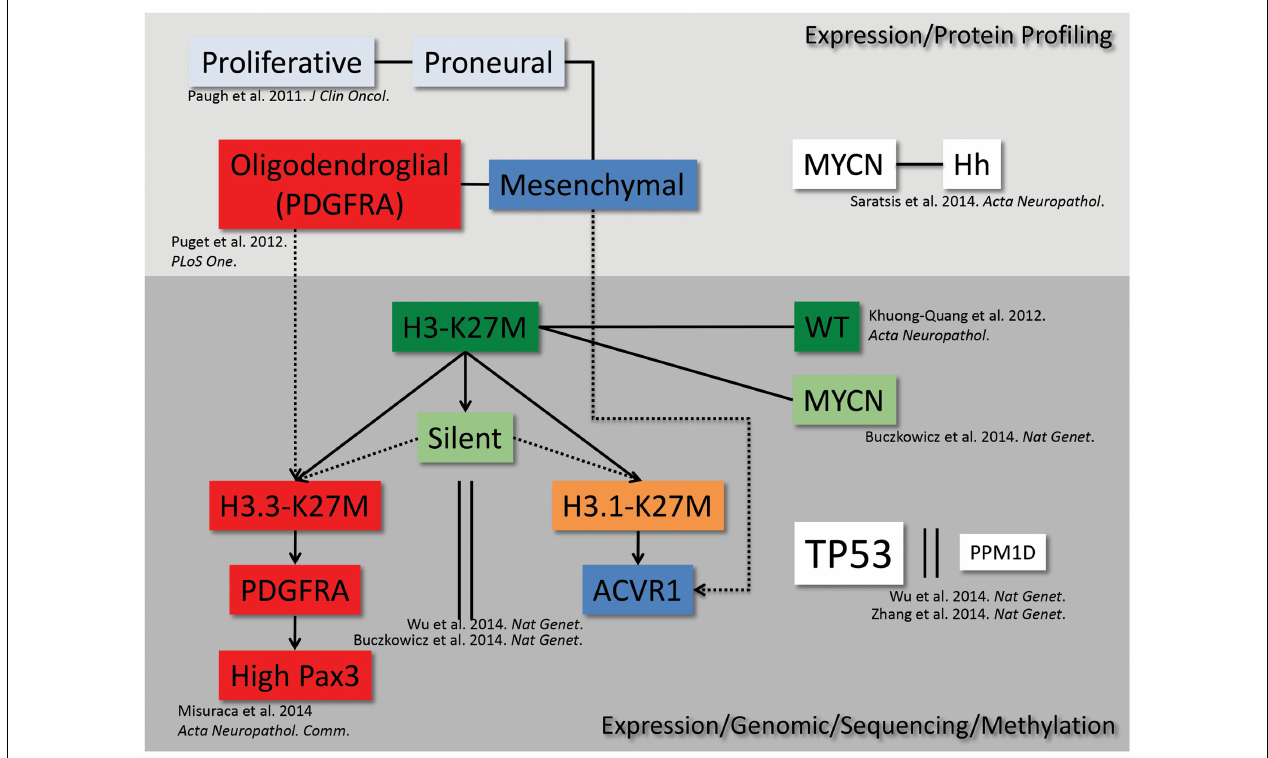
FIGURE 1 | DIPG subgrouping . From high-throughput genetic, epigenetic, proteomic, and sequencing analyses, we map the current understanding of the interrelated subgroups within DIPG.